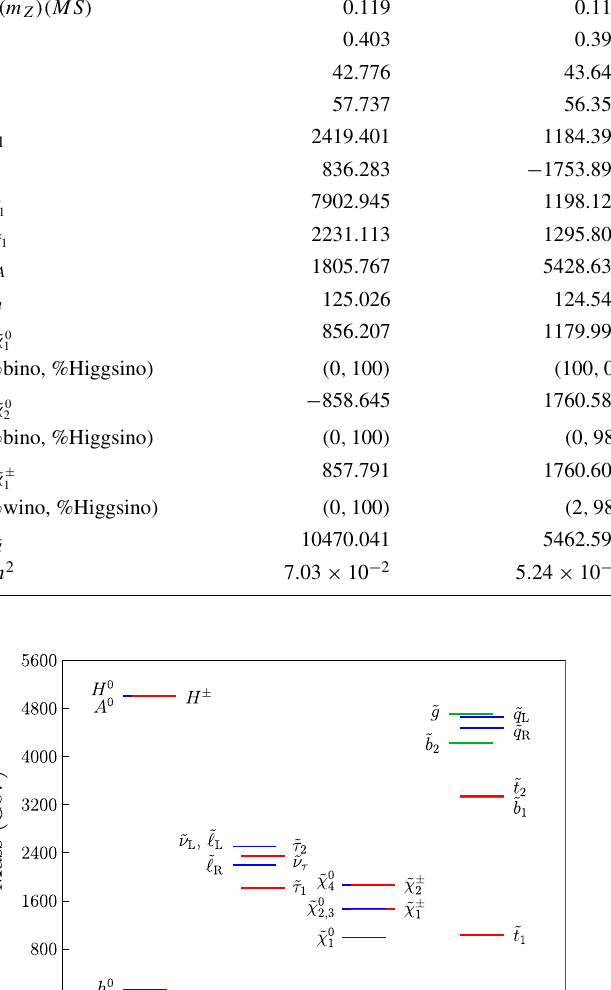
DM. The best-fit point in the chargino co-annihilation region ± , ˜ χ 0 and ˜ χ masses, but escapes LHC has small ˜ χ 0 1 1 2